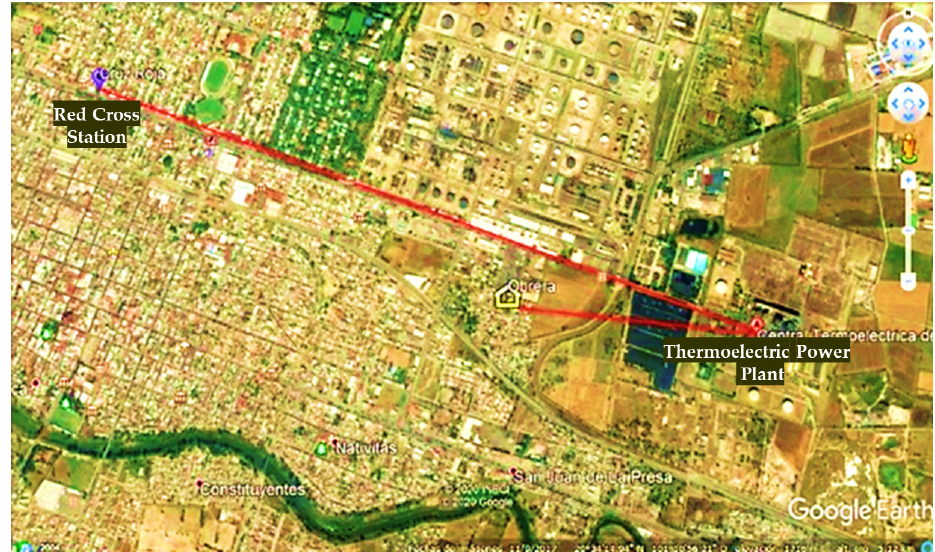
Figure 3. Tract and dispersion of SO 2 are indicated in the closest neighborhood on Salamanca´s Map from the TTP emission source monitored by the Red Cross station. Source: Adapted from Google Earth (2020) [32].